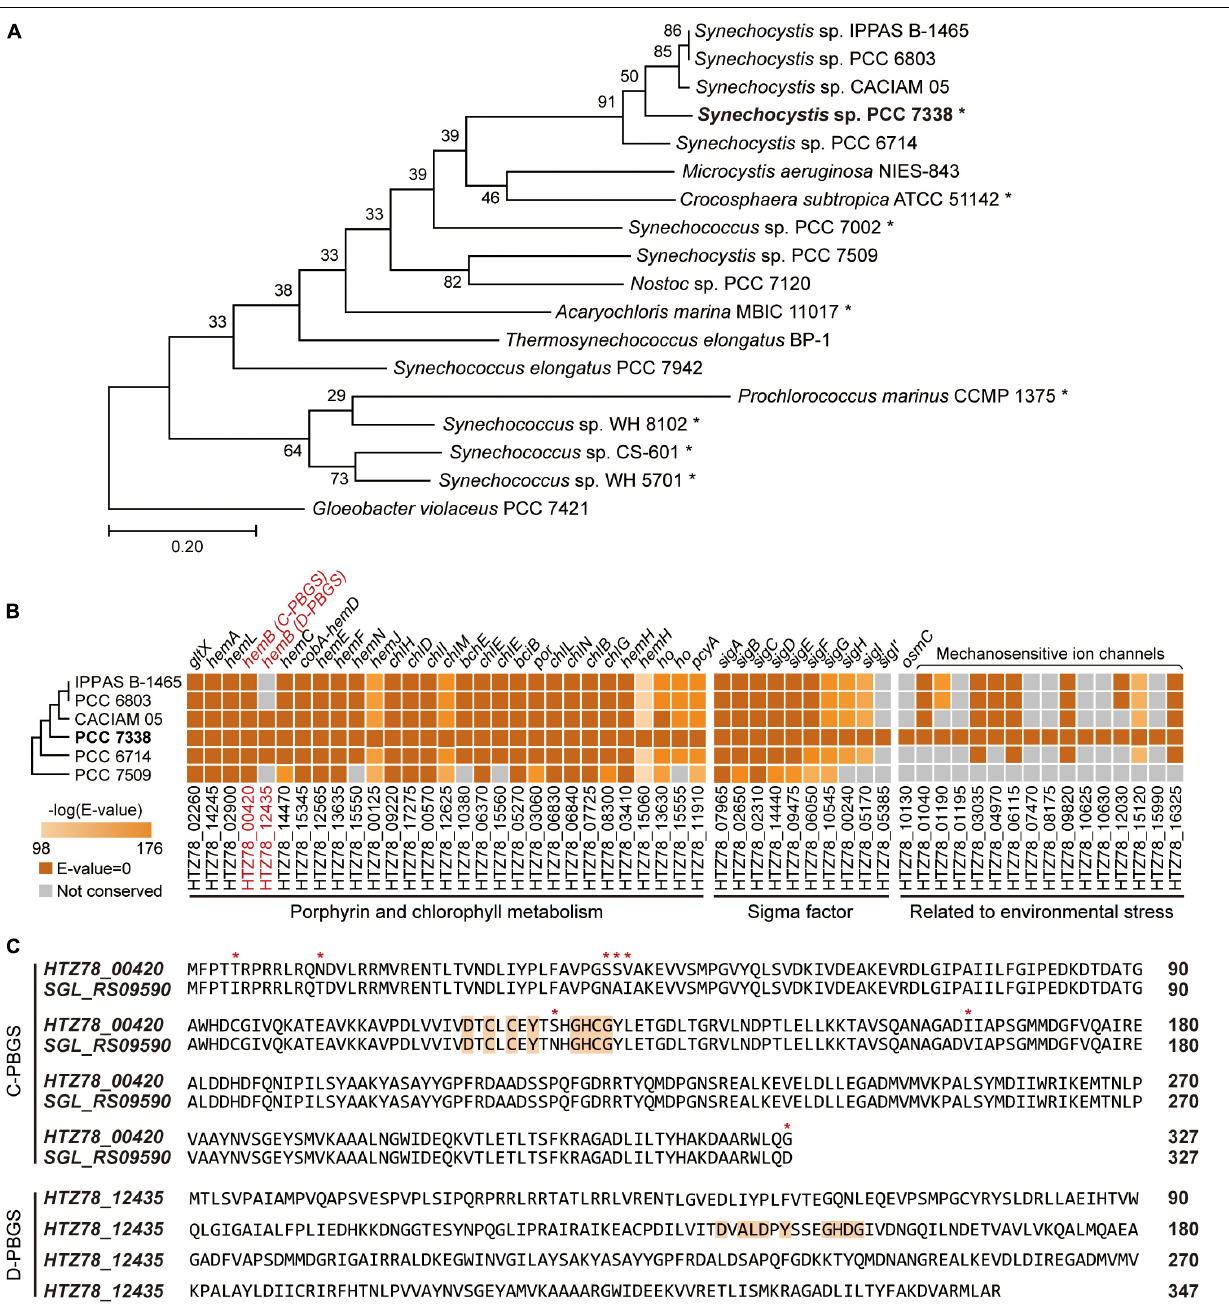
Frontiers in Microbiology |